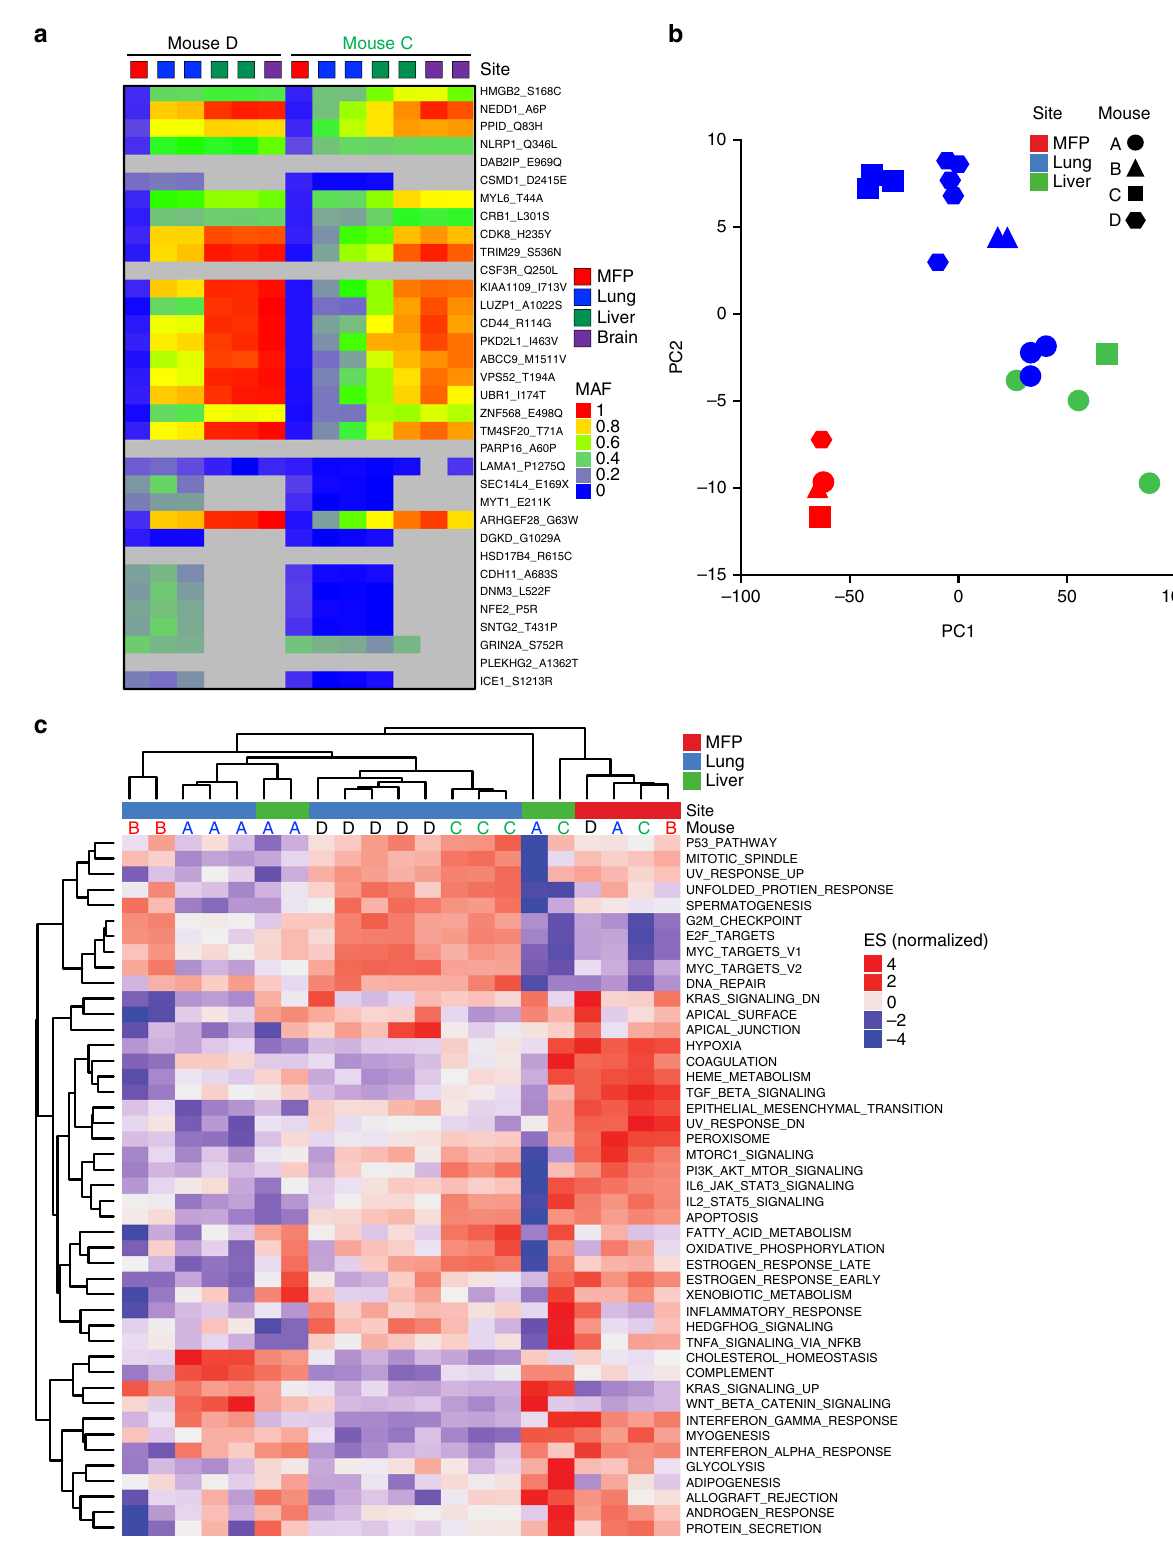
Fig. 7 Genomic and transcriptomic characterization of metastases. a Of the 34 mutations found to be signi fi cantly enriched in PIM1-CBRLuc lung metastases (Fig. 2d; mutations are displayed in the same order in this fi gure), MAFs were calculated using targeted deep sequencing data generated from two barcoded mice harboring MFP tumors and lung, liver, and brain metastases. A heatmap of MAFs is shown. Grayed cells indicate insuf fi cient coverage at that genomic region in that sample for accurate assessment of MAF. b Principal component analysis (PCA) of RNA-seq data was conducted. c GSVA pathways are shown in a heatmap of normalized enrichment scores organized by unsupervised hierarchical